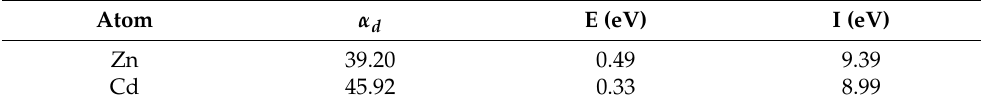
Table 1. Values adopted for the static dipole polarizabilities α d (in a 3 cutoff radius r c (in a 0 ) that reproduces the position (E (eV)) of the p-wave shape resonances at the energies reported by Burrow et al. [4]. I (eV) denotes the ionization potentials for each target [31].